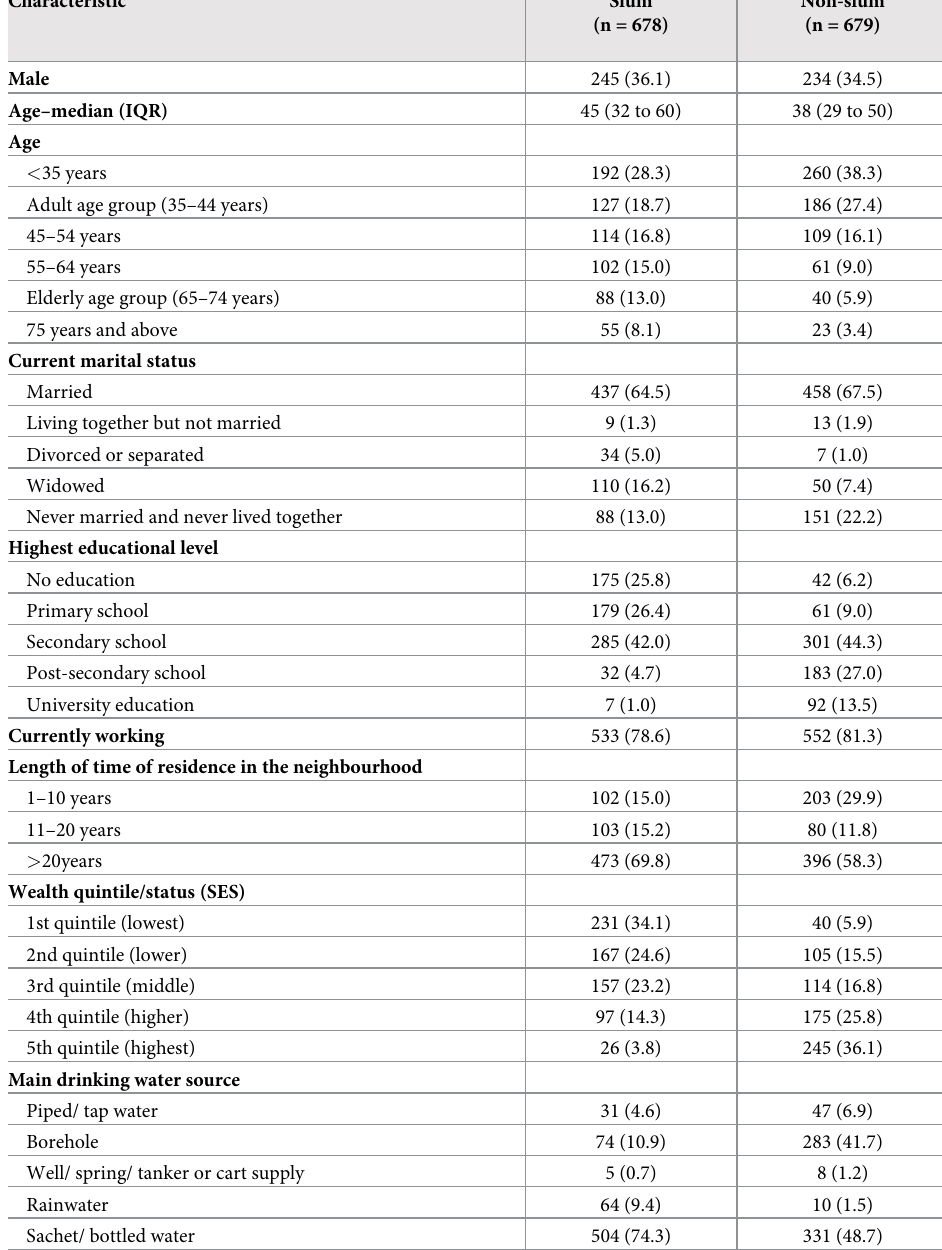
Table 1. Baseline characteristics by place of